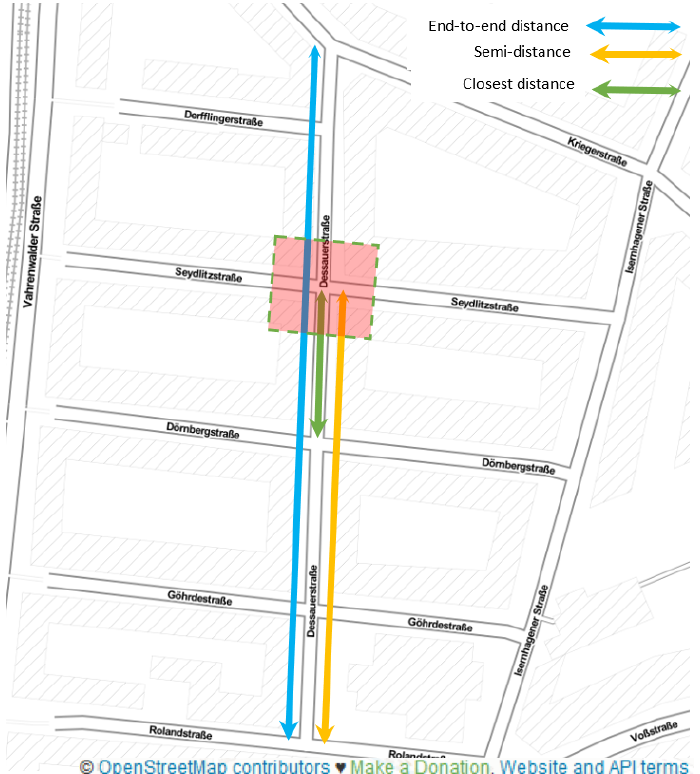
Figure 9. Illustration of the distance-related features of the static model along the north–south intersection approach of a four-way intersection (shown in